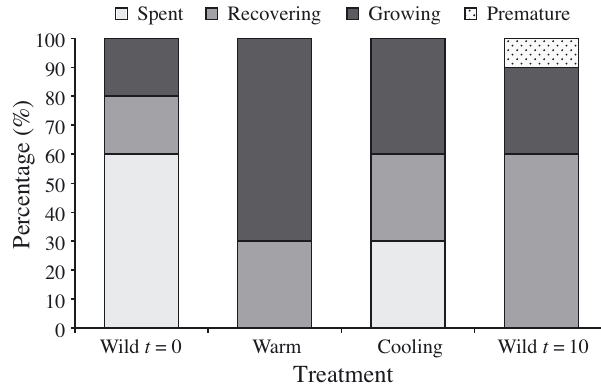
Fig. 6. Expt 3: (a) mean ± 95% confidence interval gonad index (%) between purple urchins collected from the wild at the start (Wild t = 0) and end of the experiment (Wild t = 10), and urchins fed a pellet diet and held at 22°C (Warm) and at gradually declining water tem- peratures (18−15.5°C; Cooling). Urchins were collected from Williamstown, Victoria in March 2016 ( t = 0) and May 2016 ( t = 10). Mean ± SE (b) brightness, (c) chroma and (d) hue of urchins conditioned in gradu- ally declining water tempera- tures (18−15.5°C; Cooling), at 22°C (Warm) and urchins col- lected from the wild (Wild t = 10)